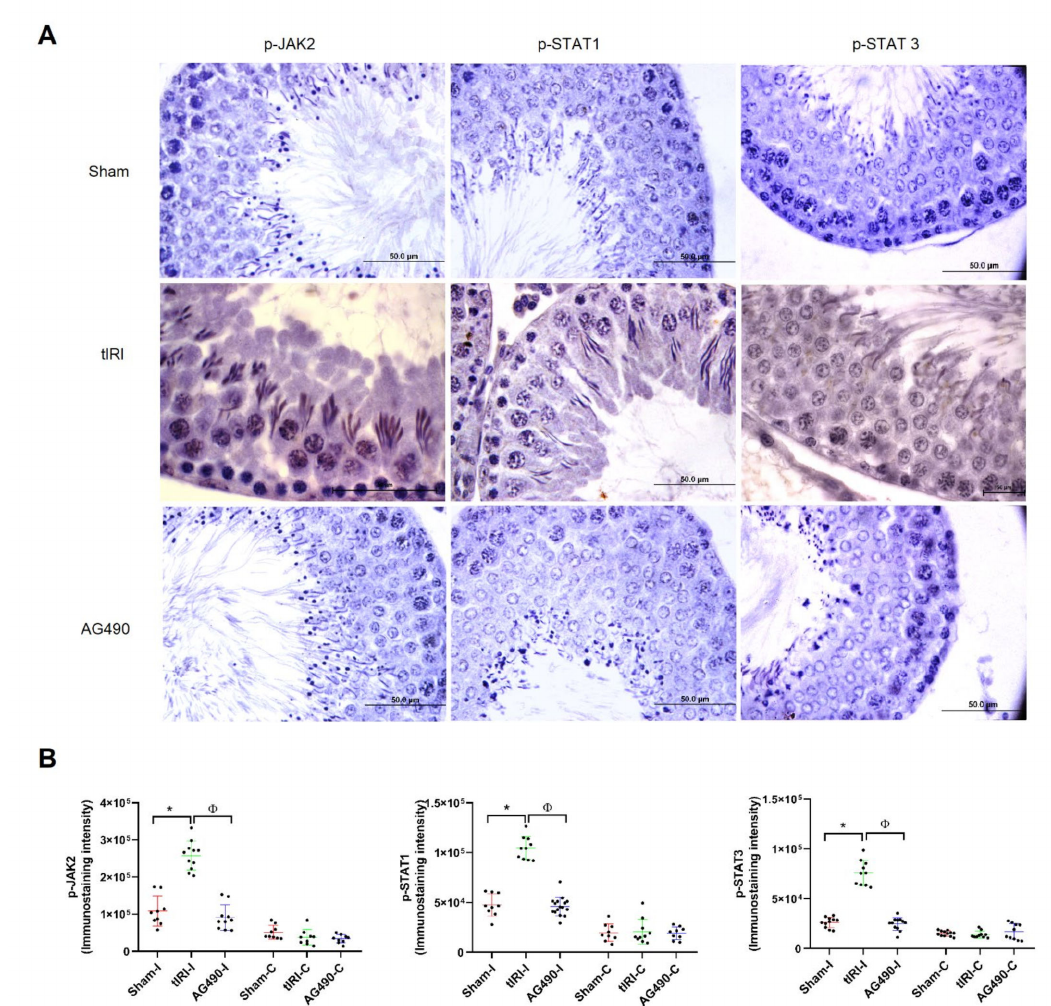
Figure 1. The JAK2/STAT1/STAT3 pathway is directly involved in tIRI. ( A ) Immunoexpression of p-JAK2/p-STAT1 and p-SAT3 in ipsilateral testicular tissue was detected and measured by IHC using the Cell Sens Dimension software. Prominent immunostaining and hence the expression of the phosphorylated forms of JAK2, STA1 and STA3 was detected in the tIRI seminiferous tubules (STs) in comparison to sham tissues. AG490 treatment (40 mg/kg) during ischemia and prior to reperfusion diminshed the immunoexpression of p-JAK2, p-STAT1 and p-STAT1 in the STs of rat testes. ( B ) Diagrams representing the immunoexpression of p-JAK2, p-STAT1 and p-STAT3. In comparison to the ipsilateral * sham and Φ AG490-treated groups, the ipsilateral tIRI testes showed higher p-JAK2 (* p < 0.0001, Φ p < 0.0001, respectively), p-STAT1 (* p < 0.0005, Φ p < 0.0001, respectively) and p-STAT3 (* p < 0.0001, Φ p < 0.0001, respectively) indicating activation of the JAK/STAT pathway during tIRI-induced oxidative stress. The contralateral testes in all groups showed no significant differences ( p > 0.05). Data are presented as mean ± SD ( n = 6/group). * tIRI compared to sham and Φ AG490 compared to tIRI. I = Ipsilateral and C =